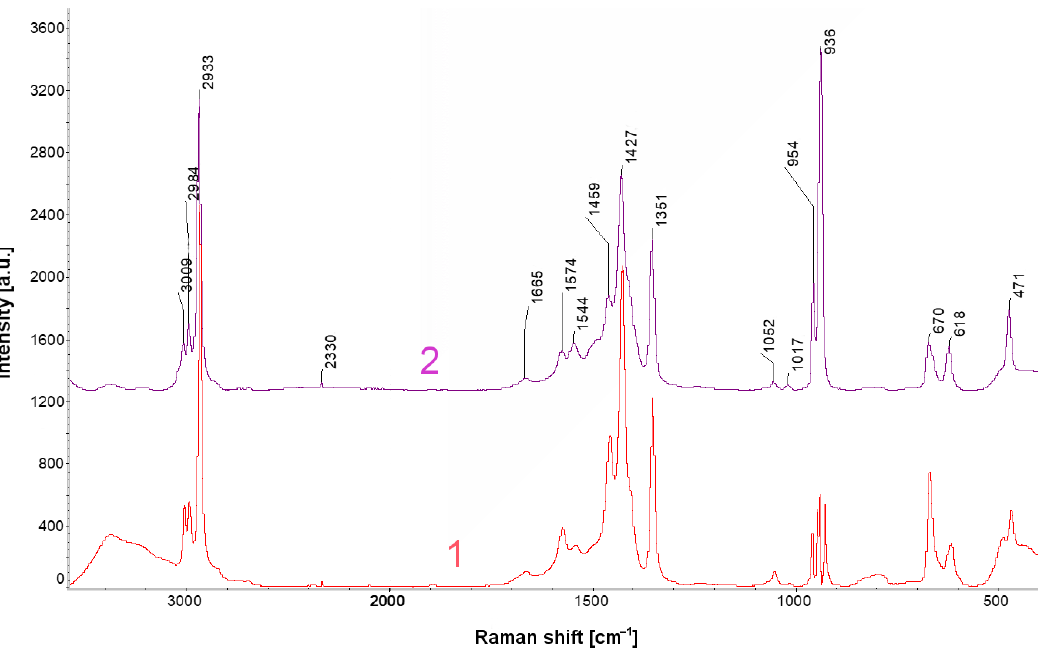
Figure 2. Comparison of Raman spectra of model lead acetate corrosion products (1) and lead acetate, Pb(CH 3 COO) 2 , standard (2).